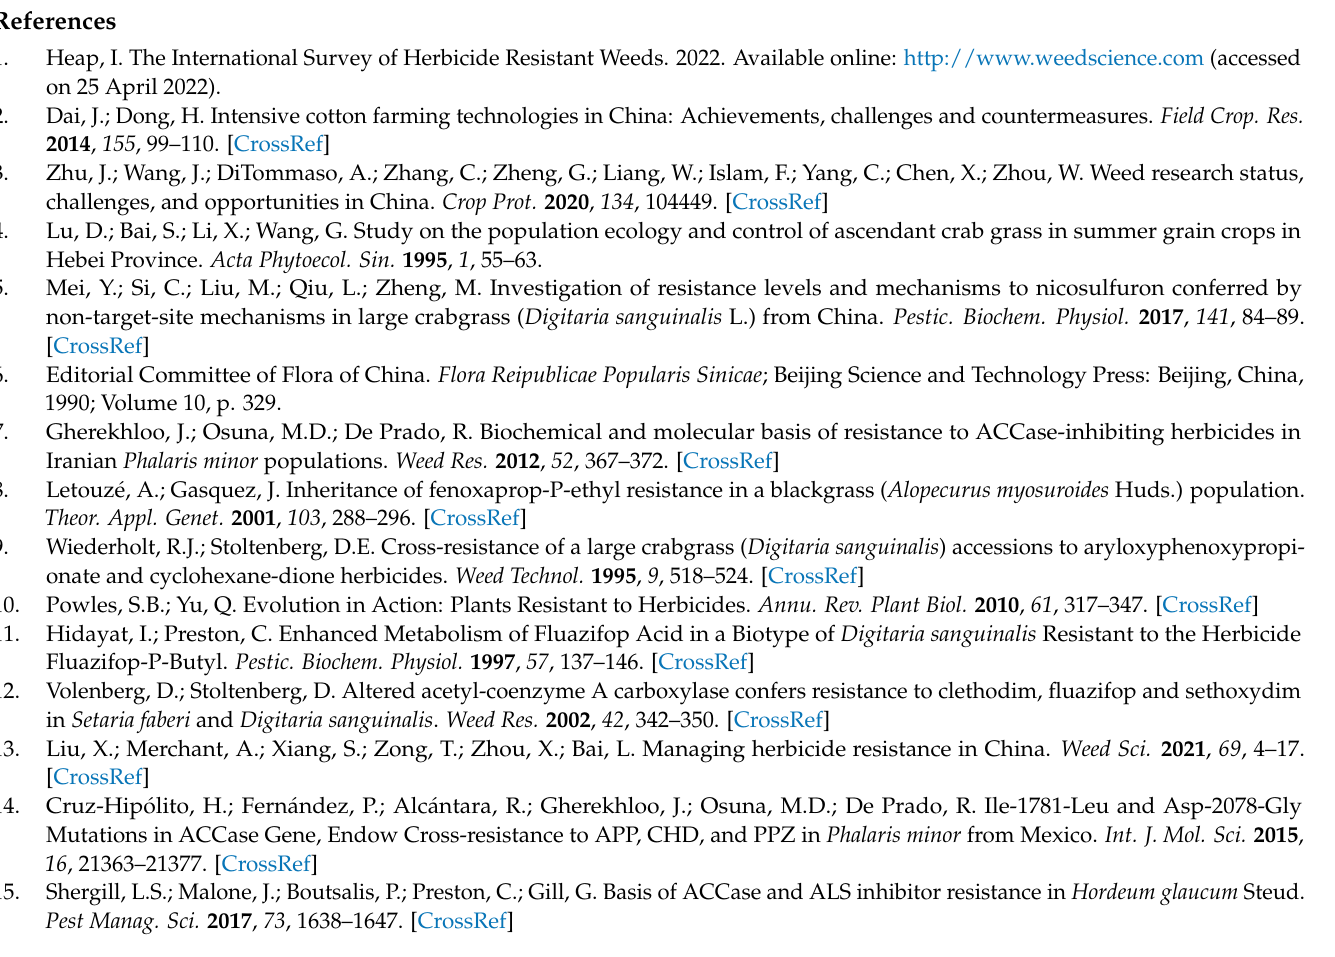
Table S2: Geographical origin of D. sanguinalis populations (2015); Table S3: Geographical origin of